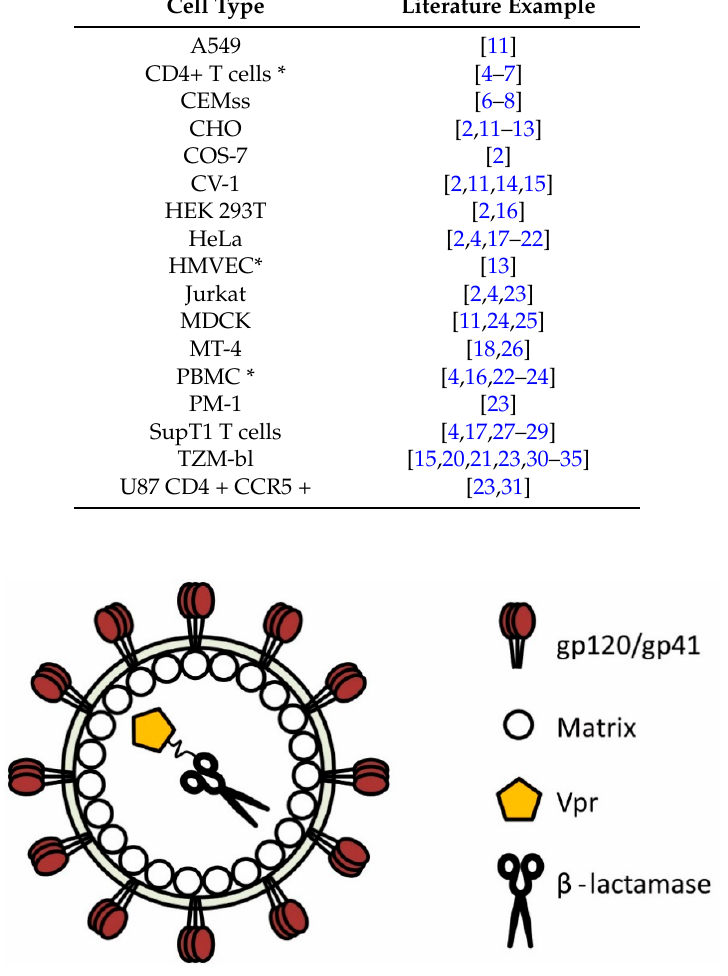
Table 1. Examples of cell lines and primary cells (denoted by *) successfully loaded with CCF2-AM and subsequently used for viral fusion analyses.